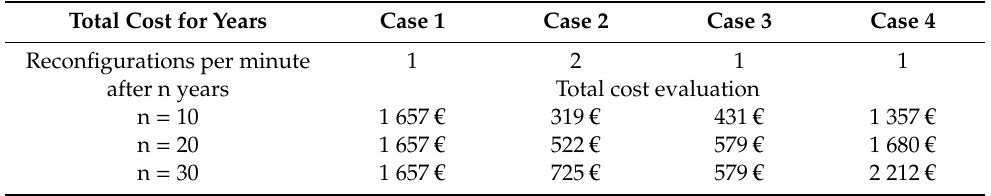
Table 8. Cost evaluation if in case 2 (case of minimum number of switches) the number of reconfigurations per minute is 2 instead of